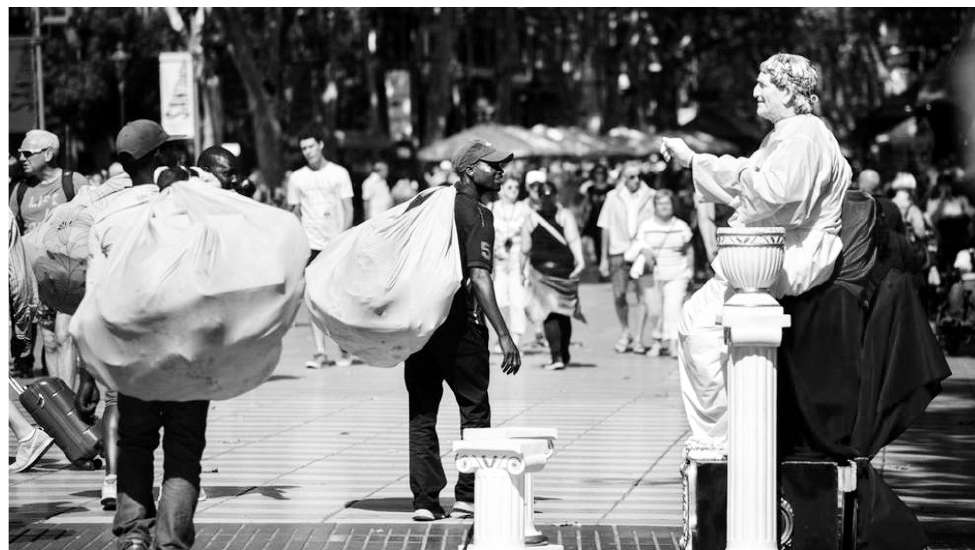
Figure 14. Everyday uses of La Rambla. “Mantas en el centro”. Source: La Vanguardia (2015). the secretion of the city, but the very substance of the city itself. The “de facto right to the city” can help us cre- ate new forms of organization and above all that new rev- olutionary